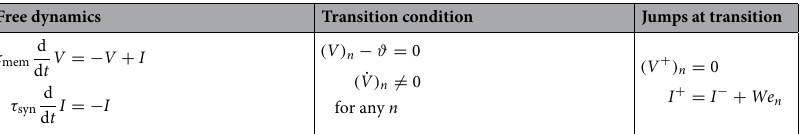
Table 1. The leaky integrate-and-fire spiking neural network model. Inbetween spikes, the vectors of membrane potentials V and synaptic currents I evolve according to the free dynamics. When some neuron n ∈ [ 1.. N ] crosses the threshold ϑ , the transition condition is fulfilled, causing a spike. This leads to a reset of N × N the membrane potential as well as post-synaptic current jumps. W ∈ R is the weight matrix with zero N diagonal and e n ∈ R is the unit vector with a 1 at index n and 0 at all other indices. We use − and + to denote quantities before and after a given spike